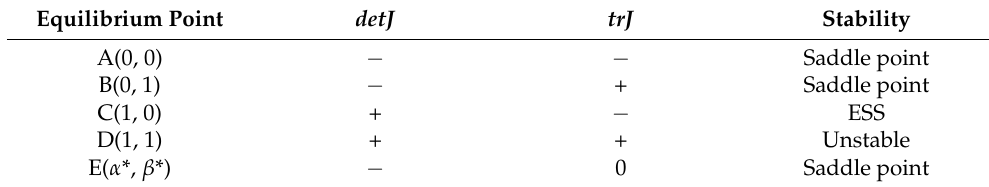
Table 10. Local stability analysis of scenario 1 between local government and the public.